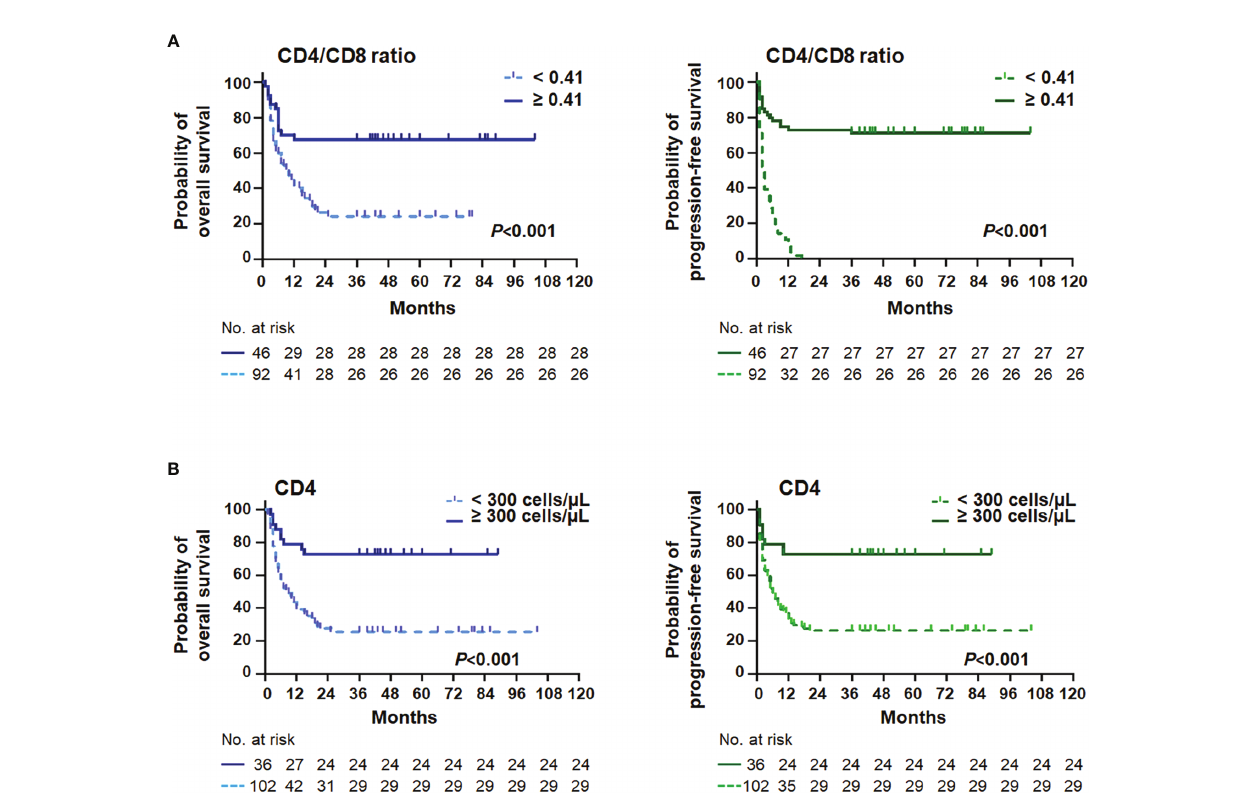
FIGURE 2 | Survival curves strati fi ed by the CD4/CD8 ratio and the CD4 + T cell. Kaplan – Meier curves and log-rank P -values of the CD4/CD8 ratio (A) and the CD4 + T-cell (B) strati fi cations for overall survival (left) and progression-free survival (right) in AIDS-related lymphoma patients ( n = 138).